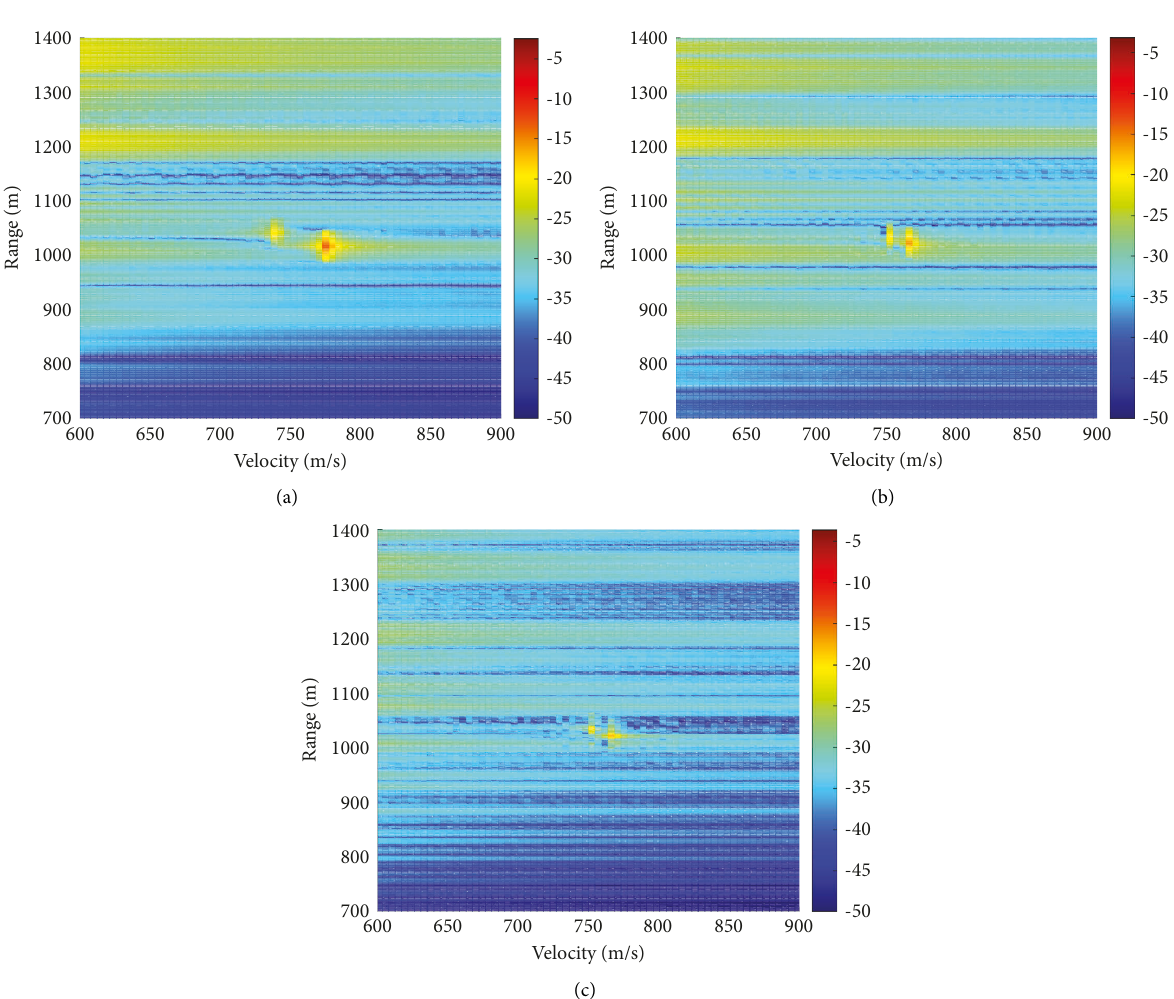
Figure 12: .The Range-Doppler spectrum under different target heights and different bandwidths (a) H � 50M, B � 10M Hz; (b) H � 20M, B � 10 M Hz; (c) H � 20M, B � 30M Hz.